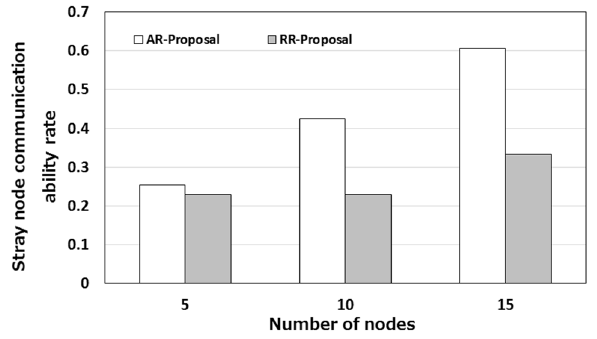
Figure 16. Stray node communication ability rate. ( a ) Stray node communication ability rates of the autonomous response-type stray node detection protocols; ( b ) stray node communication ability rates of the request-response-type stray node detection protocol; ( c ) stray node communication ability rates of the proposed protocols.